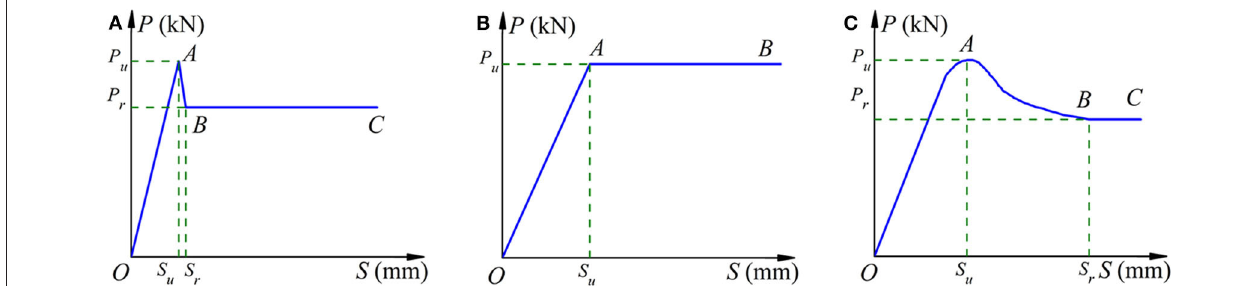
Replacement Percentage of